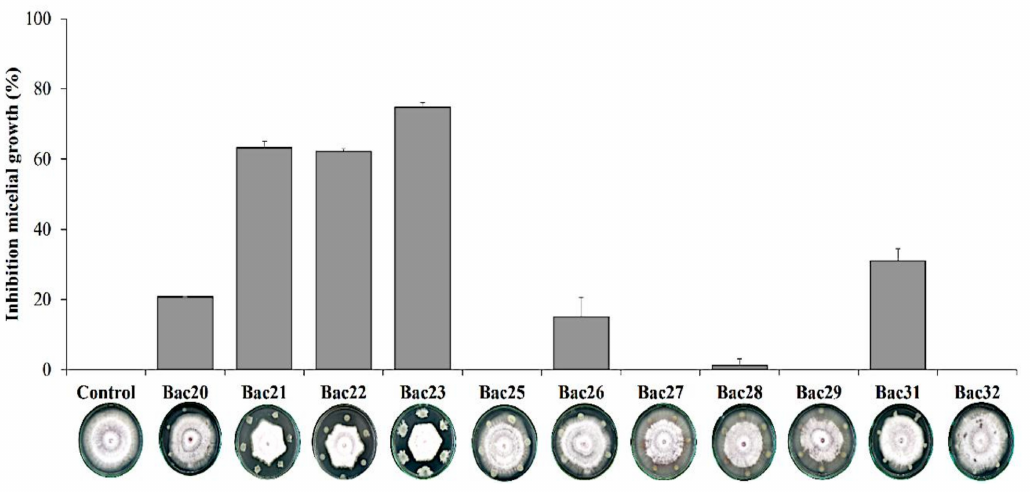
Figure 4. In vitro biocontrol activity of isolated bacteria from SOA. Inhibition of FORL in dual culture. Each bar represents the percentage of three repetitions with its standard deviation. Under each strain, a representative figure of the fungal inhibition in the Petri dish is